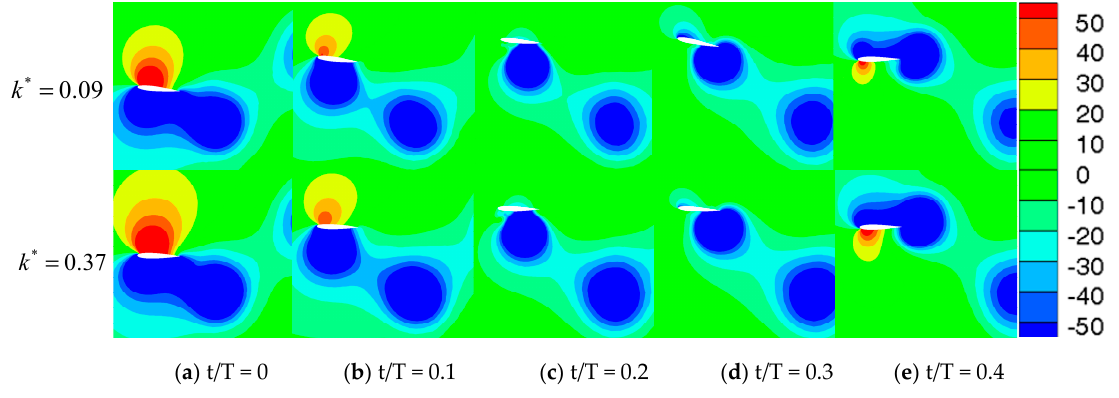
Figure 16. Instantaneous pressure contours at t/T = 0 − 0.4 for different spring stiffnesses ( 𝑘 ∗ = 0.09, 𝑘 ∗ = 0.37 , ( a ) t/T = 0, ( b ) t/T = 0.1, ( c ) t/T = 0.2, ( d ) t/T = 0.3, ( e ) t/T = 0.4).